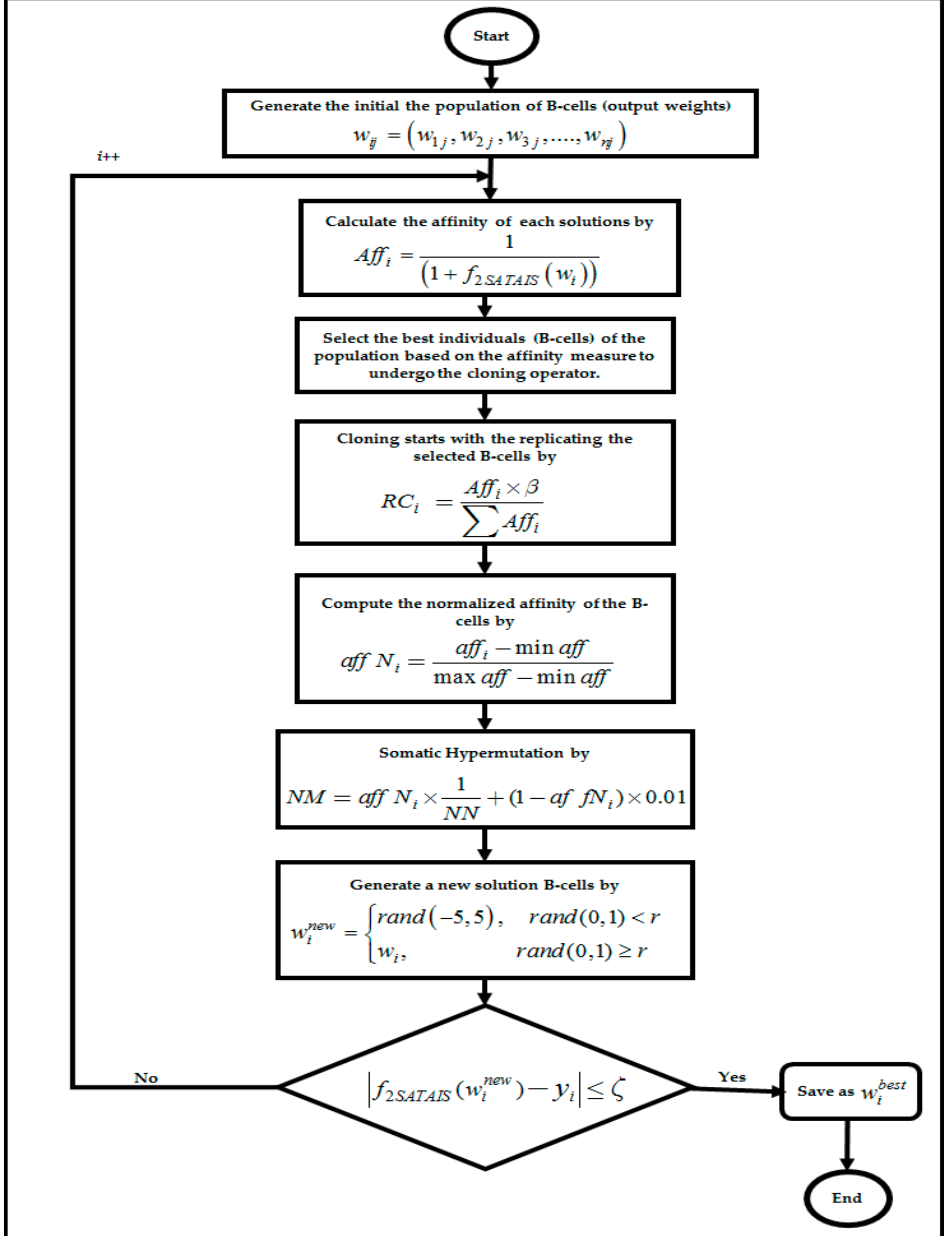
Figure 7. The implementation of the artificial immune system (AIS) algorithm in RBFNN-2SAT.